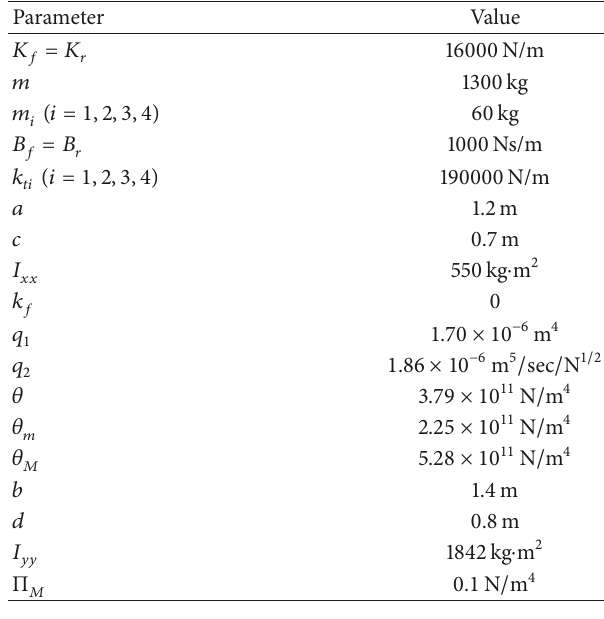
Table 2: Structure parameters.